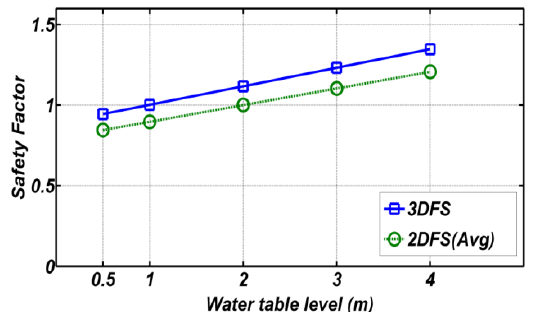
Figure 4. Influence of the water table level on the safety factor.